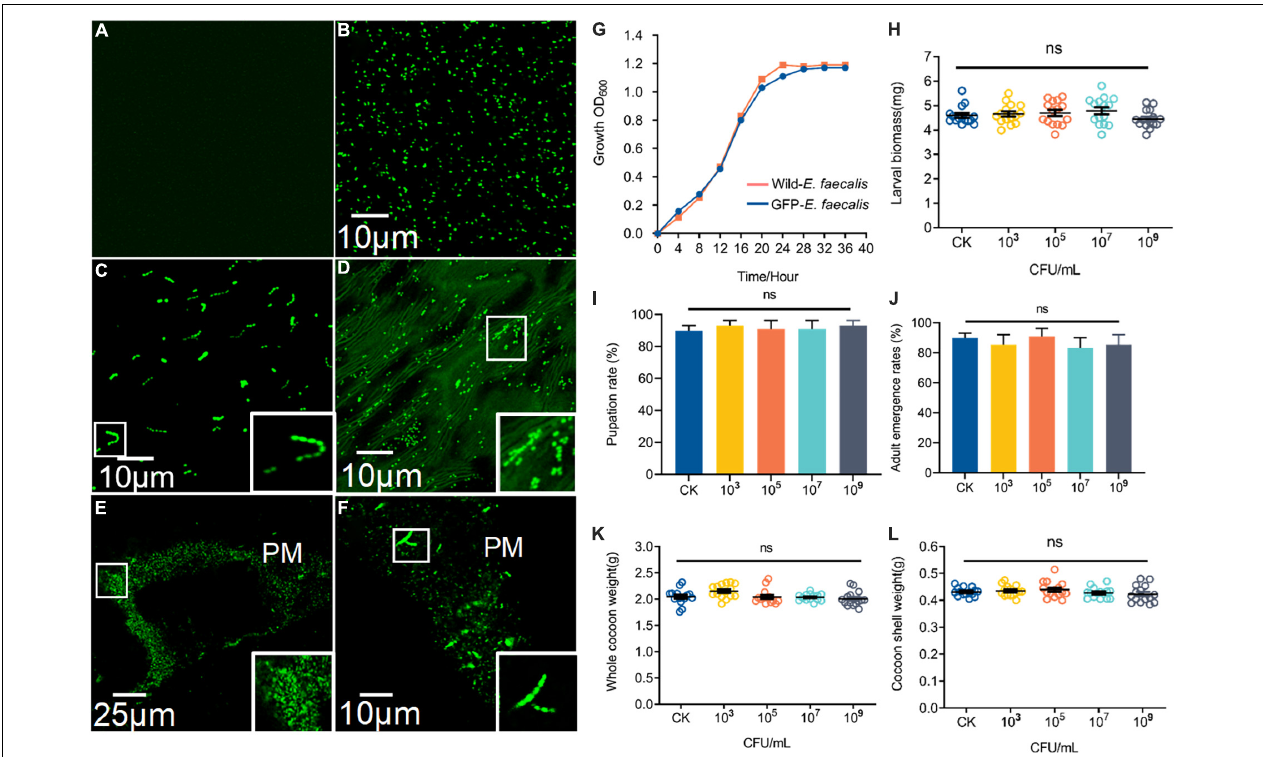
FIGURE 2 | Characteristics and colonization of GFP–expressing E. faecalis in the B. mori intestinal tract. (A) Fluorescence micrographs of wild-type (CK) E. faecalis grown in THB. (B) Fluorescence micrographs of GFP–expressing E. faecalis under the control of pTRKH3–ermGFP. Scale bar = 10 µ m. (C) GFP- E. faecalis grown for 12 h in the presence of intestinal juice and THB (1:1). Scale bar = 10 µ m. (D) Fluorescent image of the gut contents of 5th-instar larvae after feeding on GFP– E. faecalis for 5 days. Scale bar = 10 µ m. (E) Large clumps of GFP– E. faecalis adhE red to the peritrophic membrane of gut tissue. Scale bar = 25 µ m. (F) Enterococcus with a chain–like structure was immobilized on the peritrophic membrane. Scale bar = 10 µ m. (G) Shows the growth of these wild-type– E. faecalis and GFP– E. faecalis. The larval masses (H) , pupation (I) , whole cocoon weight (J) and adult emergence rates (K) , and cocoon shell weight (L) of normal and 10 3 , 10 6 , and 10 9 CFU/mL E. faecalis –treated silkworms, respectively. Healthy silkworms treated with the same volume of sterilized water were used as the control group (CK). Different letters represent significant differences between groups according to Tukey’s honestly significant difference test (HSD, p < 0.05). Boxes show